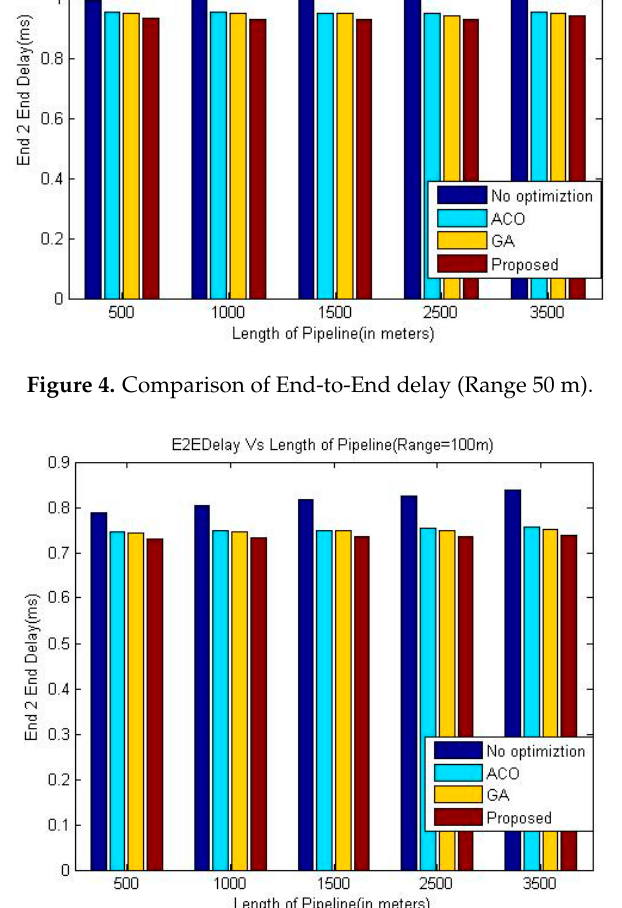
Figure 5. Comparison of End-to-End delay (Range100 m).